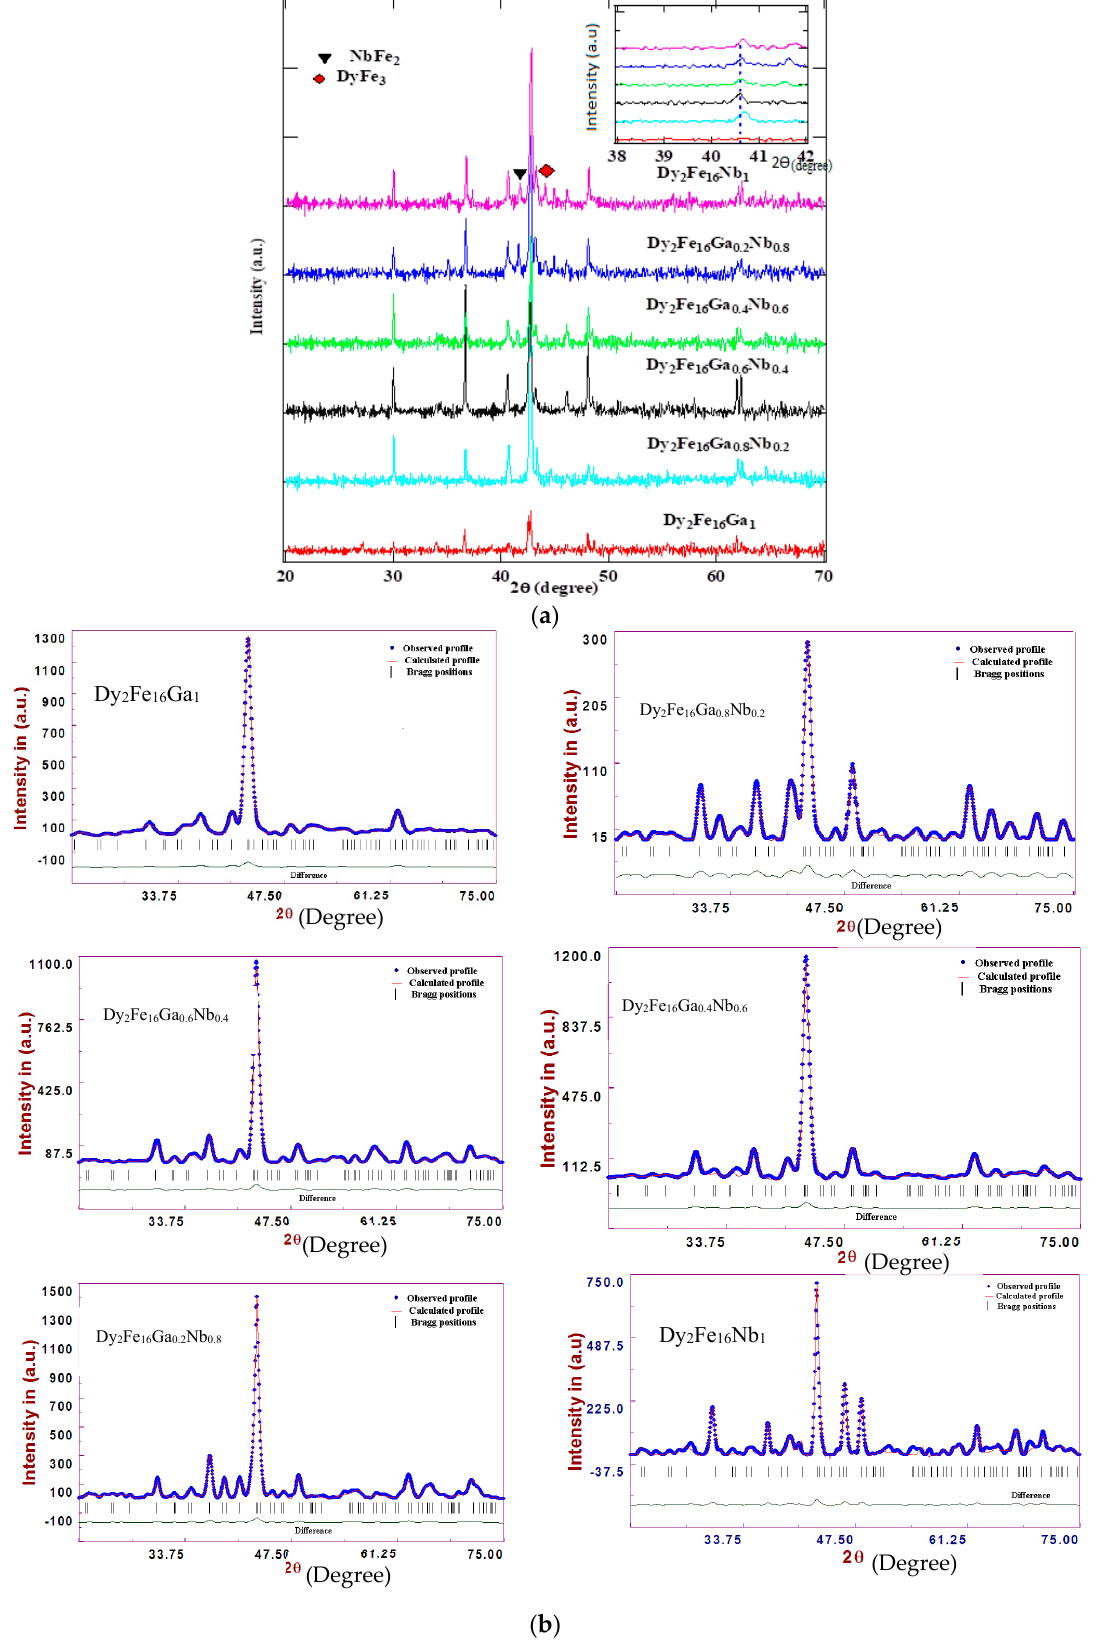
Figure 1. ( a ) X-ray diffraction patterns of Dy 2 Fe 16 Ga 1 − x Nb x compounds. ( b ) Rietveld refinement profile for Dy 2 Fe 16 Ga 1 − x Nb x .